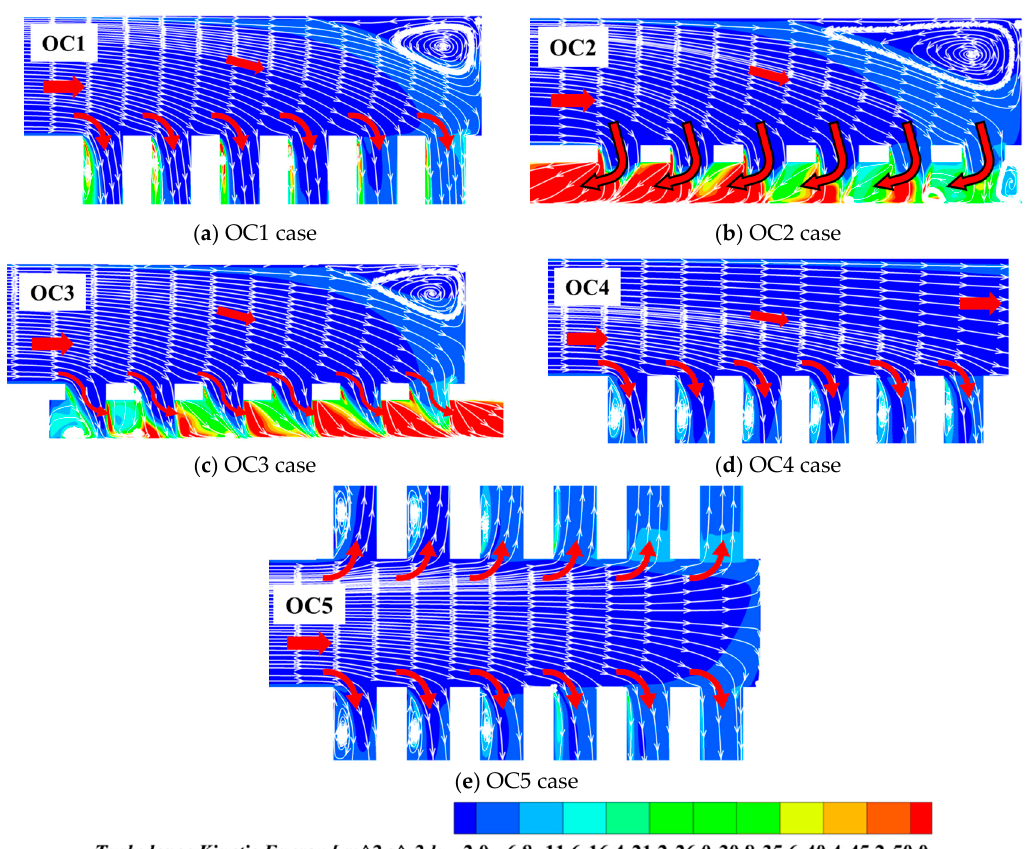
Figure 6. Streamlines and TKE distributions on the longitudinally middle sections for different outlet configurations, Re = 30,000.